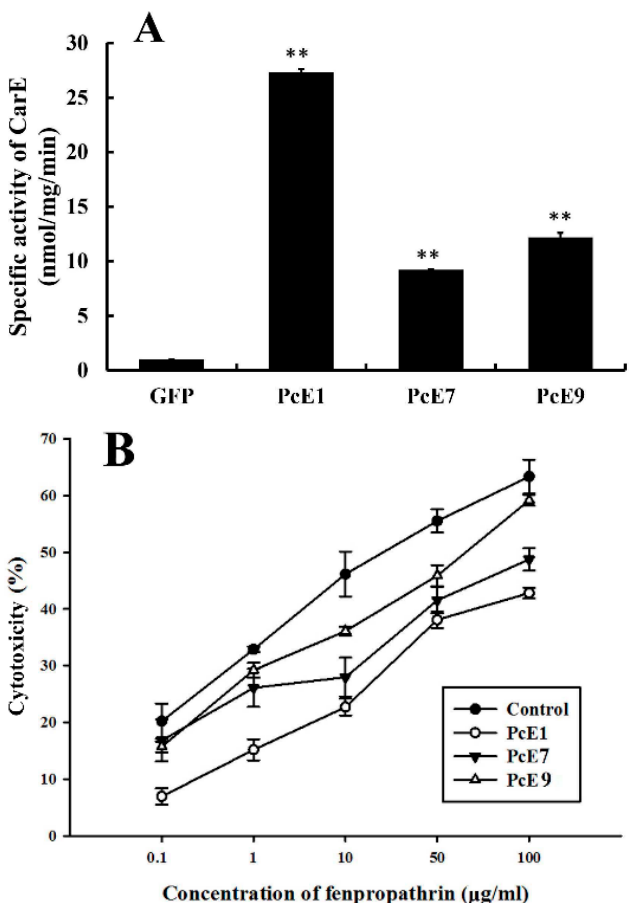
Figure 4. Specific activity of carboxylesterase (CarE) in recombinant enzymes expressing PcE1 , PcE7 or PcE9 toward the substrate of α -NA ( A ); and cytotoxicity of PcE1- , PcE7- , PcE9- and EGFP-expressing cells against fenpropathrin ( B ). The percentage of viable cells was detected using 3-(4,5-dimethyl-2-yl)-2,5-diphenyltetrazolium bromide cytotoxicity assays. Data are means ± SE of three independent experiments. Asterisks (*) above the error bars indicate statistical differences determined by the independent samples t -test (** p < 0.01).